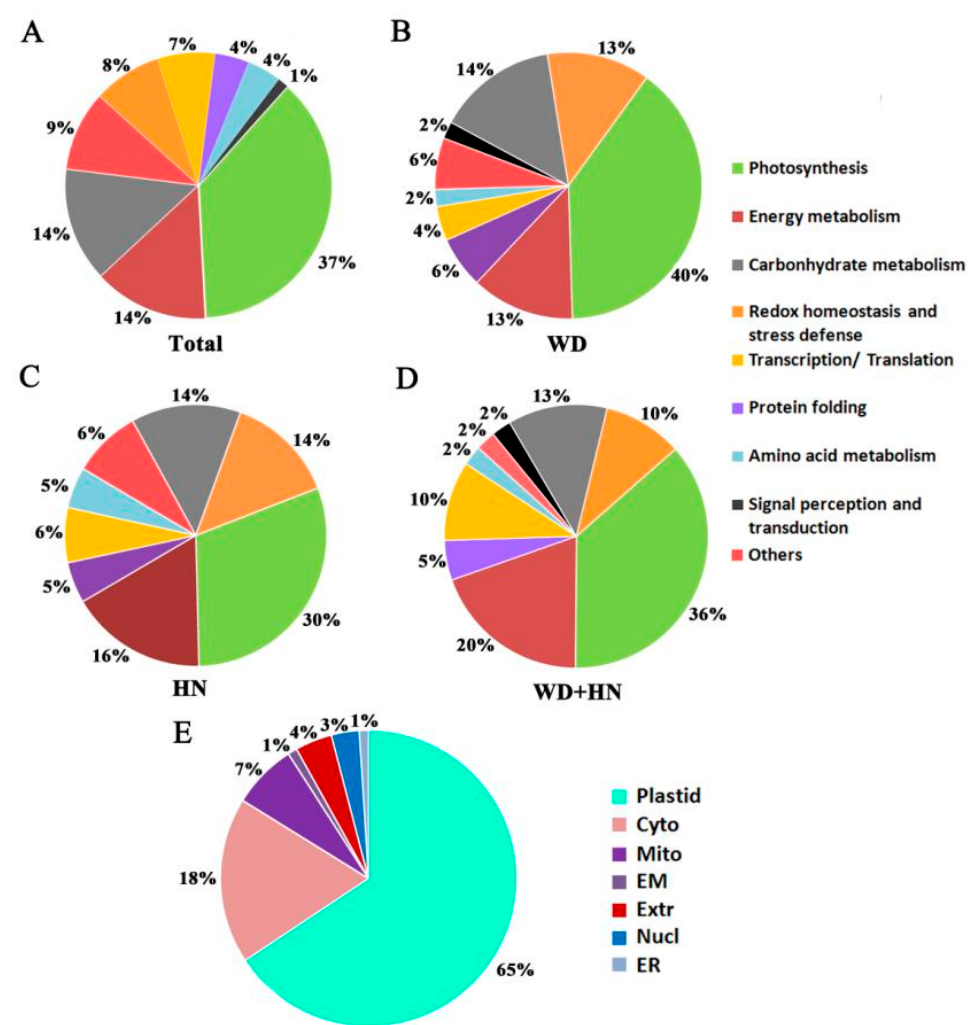
Figure 4. Functional classification and subcellular localization of 72 identified differentially accumulated protein (DAP) spots from wheat flag leaves under water-deficit, high-nitrogen (N) fertilization, and combined treatments. ( A ) Functional classification of total DAP spots. ( B ) Functional classification of DAP spots in the water-deficit treatment (WD). ( C ) Functional classification of DAP spots in the high-N treatment (HN). ( D ) Functional classification of DAP spots in the combined treatments (WD+HN). ( E ) Subcellular localization: Chl, chloroplast; Nucl, nuclear; Cyto, cytoplasm; Extr, extracellular; Mito, mitochondria; EM, endomembrane; ER, endoplasmic reticulum.